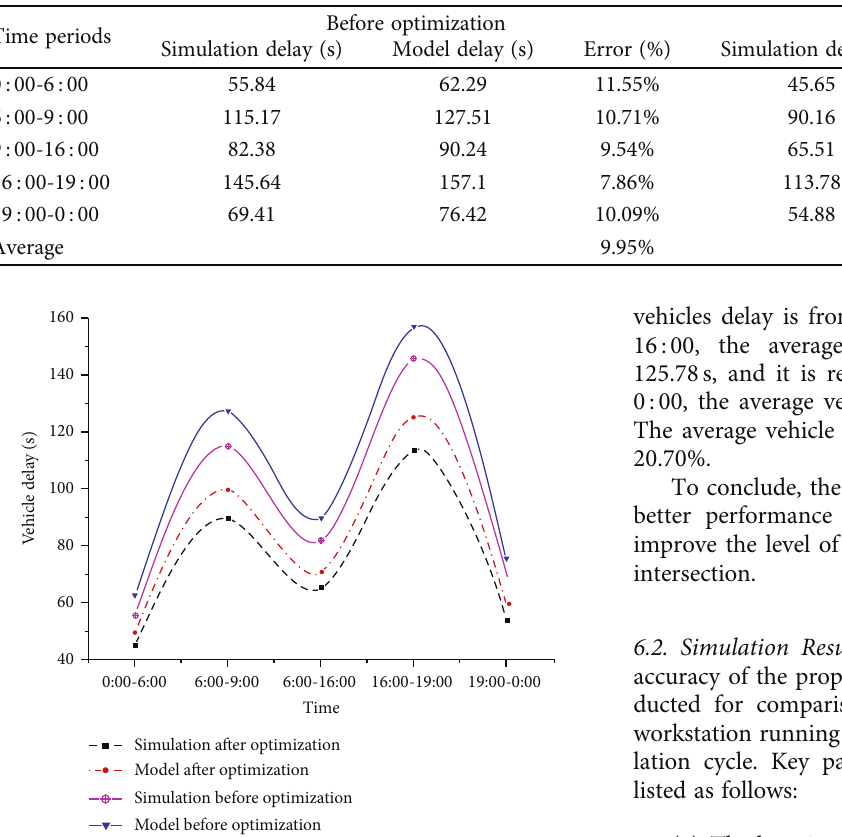
Table 8: Comparison of model calculation results and simulation results.